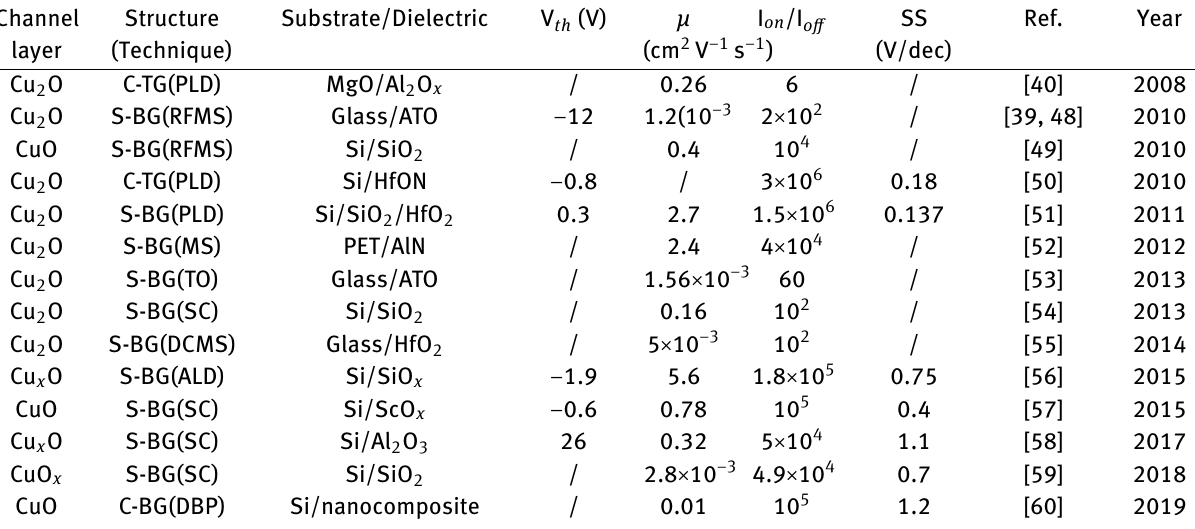
Table 1: Short-review of the reported p-type copper oxide TFTs